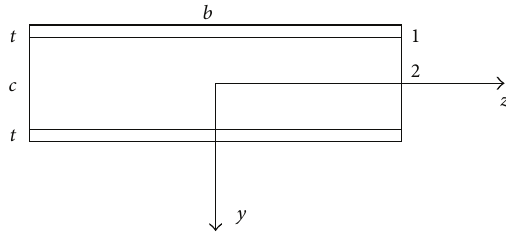
Figure 12: Section of the sandwich